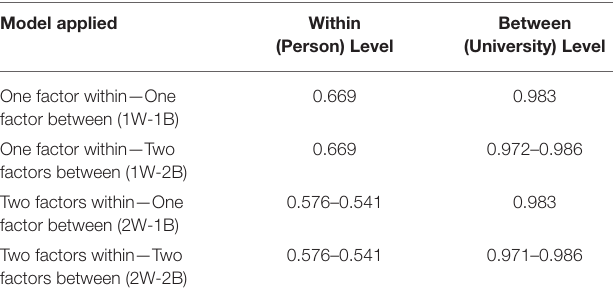
TABLE 4 | Omega reliability coefficients for the tested multilevel models ( N = 1,696). Model